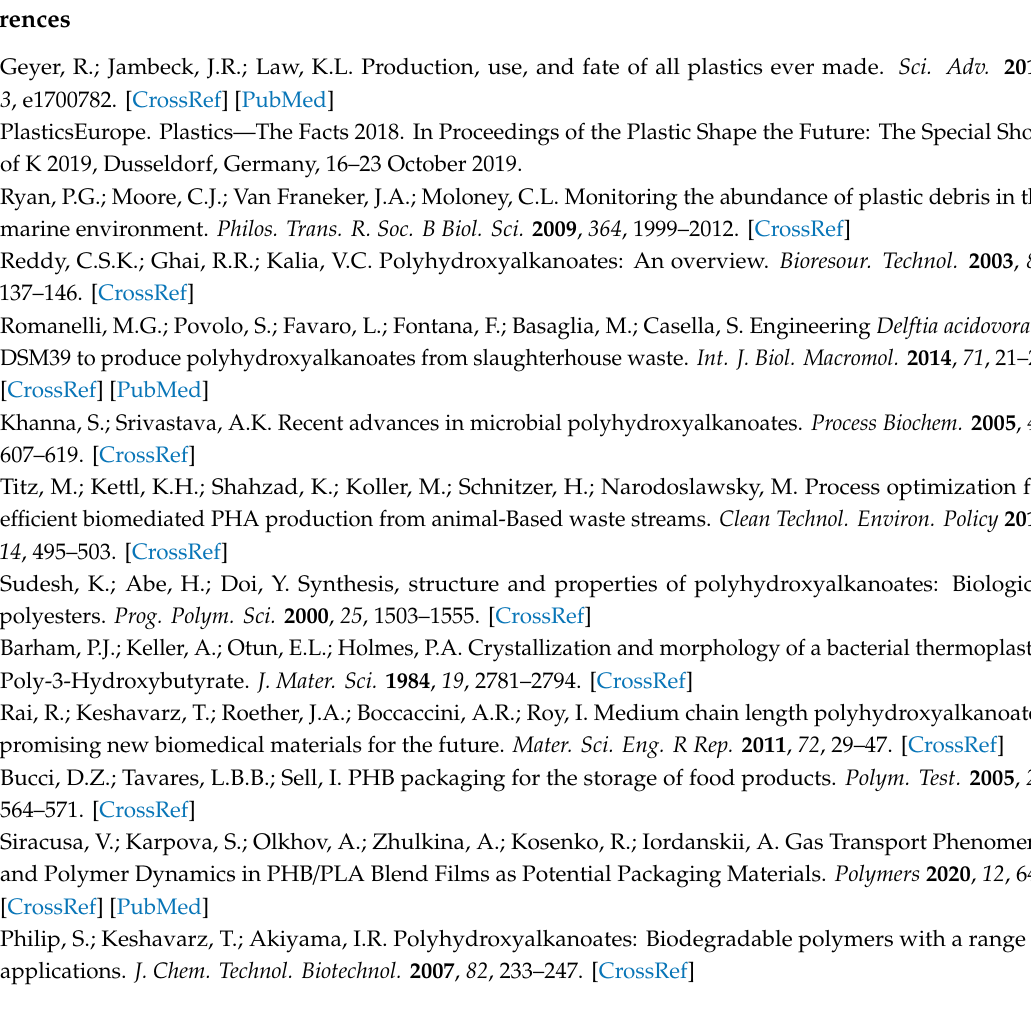
Figure S1: Gas chromatography (GC) analysis of 3-hydroxybutyric acid (3HB) methyl ester, after chloroform extraction, in dry cells of C. necator DSM 545 grown for 96 h in SSF of broken rice (3% w / v ) and STARGEN ™ 002 (1.42 µ L per g of starch). GC analysis reveals that 3HB was the only polymer accumulated by C. necator DSM 545. I.S. stands for internal standard (benzoic acid). Figure S2: Gas chromatography (GC) analysis of 3-hydroxybutyric acid (3HB) methyl ester, after chloroform extraction, in dry cells of C. necator DSM 545 grown for 96 h in SSF of purple sweet potato (3% w / v ) and STARGEN ™ 002 (1.42 µ L per g of starch). GC analysis reveals that 3HB